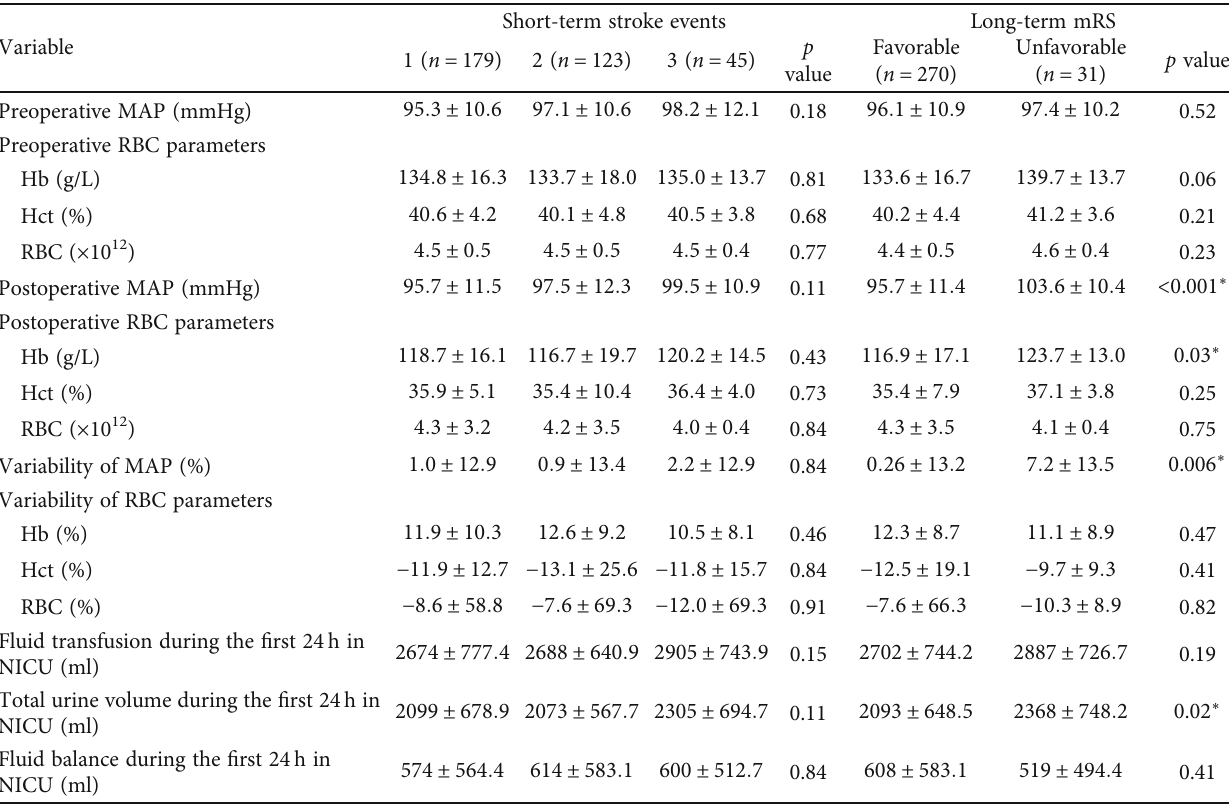
Table 2: Characteristics of perioperative hemodynamic parameters grouped by short-term stroke events and long-term mRS. Variable